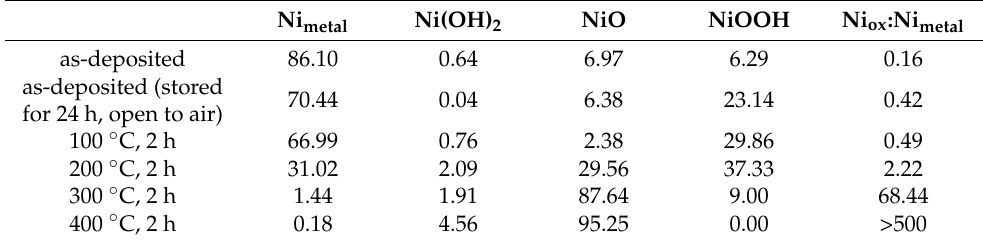
Table 3. Shares of oxidized forms of Ni (in %) detected on the surface of nickel coatings depending on their post-deposition heat treatment temperature. The compositions listed above concern the surface analyzed in the “as received” state (i.e., without Ar + sputter